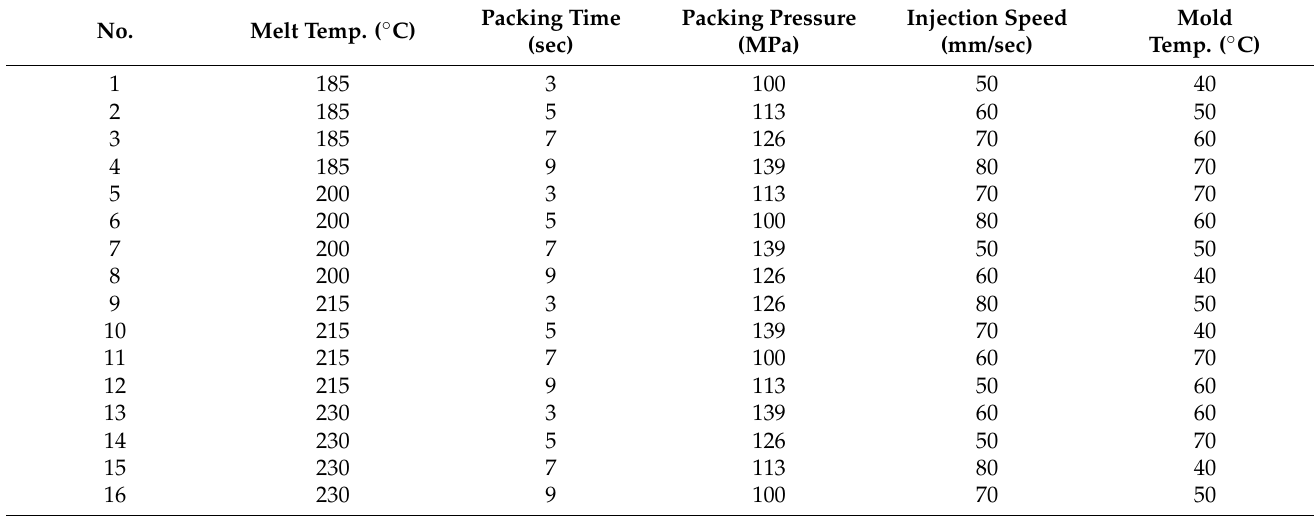
Table 18. Training data for the round plate model